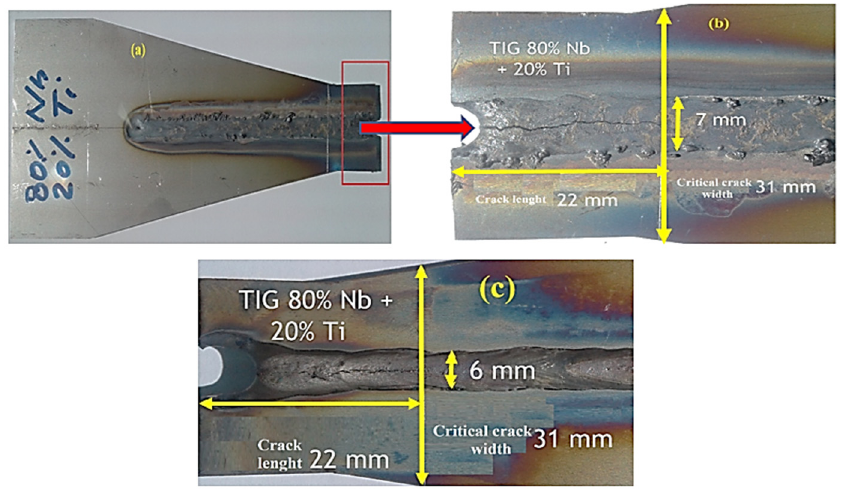
Figure 7. Welded specimen coated with the mixture of powders (80% Nb + 20% Ti), face side ( a ), enlarged of marked area ( b ) and back side of enlarged marked area ( c ).